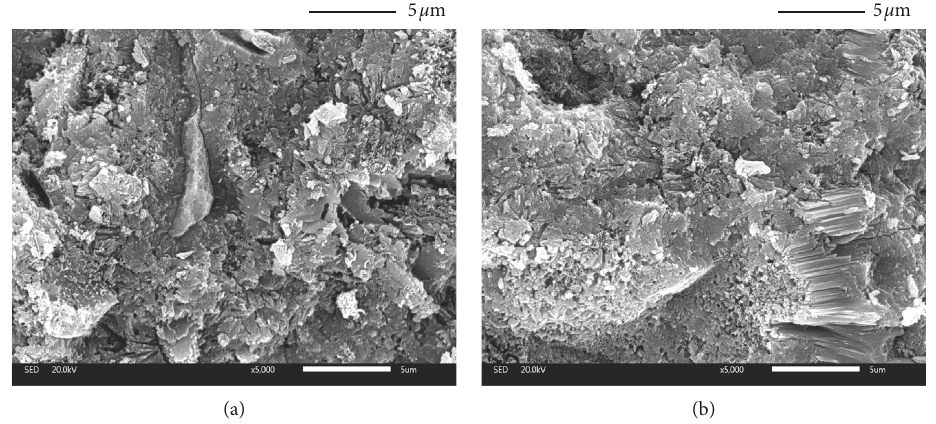
Figure 7: Typical SEM images of specimens hydrated for 90days. (a) PS40, (b)